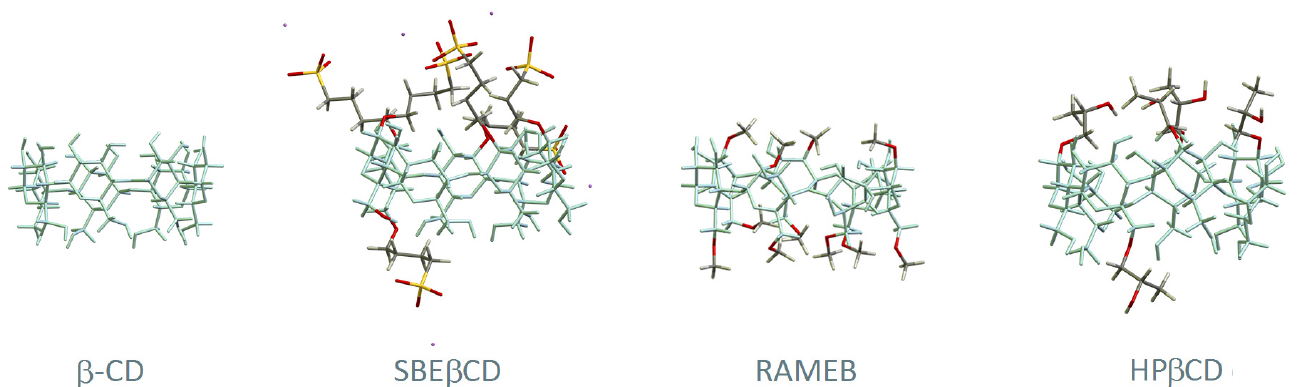
Figure 2. Structural representation of β -CD and three of its derivatives: (2-hydroxy)propyl-beta-cyclodextrin (HP β CD), randomly methylated beta-cyclodextrin (RAMEB), and sulfobutyl ether β -CD (SBE β CD). The main skeleton of β -CD is represented in blue and the substituent groups are highlighted with different colours (carbon in grey, oxygen in red, hydrogen in white, sulphur in yellow and sodium in purple). Table 1. Summary of pharmaceutical products containing native and chemically modified cyclodextrins, their allowed daily intake from oral intake (ADI), restrictions to use (maximal dose), and main toxicity issues. Pharmaceutical Dosage Forms Cyclodextrin ADI/Max Dose Toxicity Concerns Oral